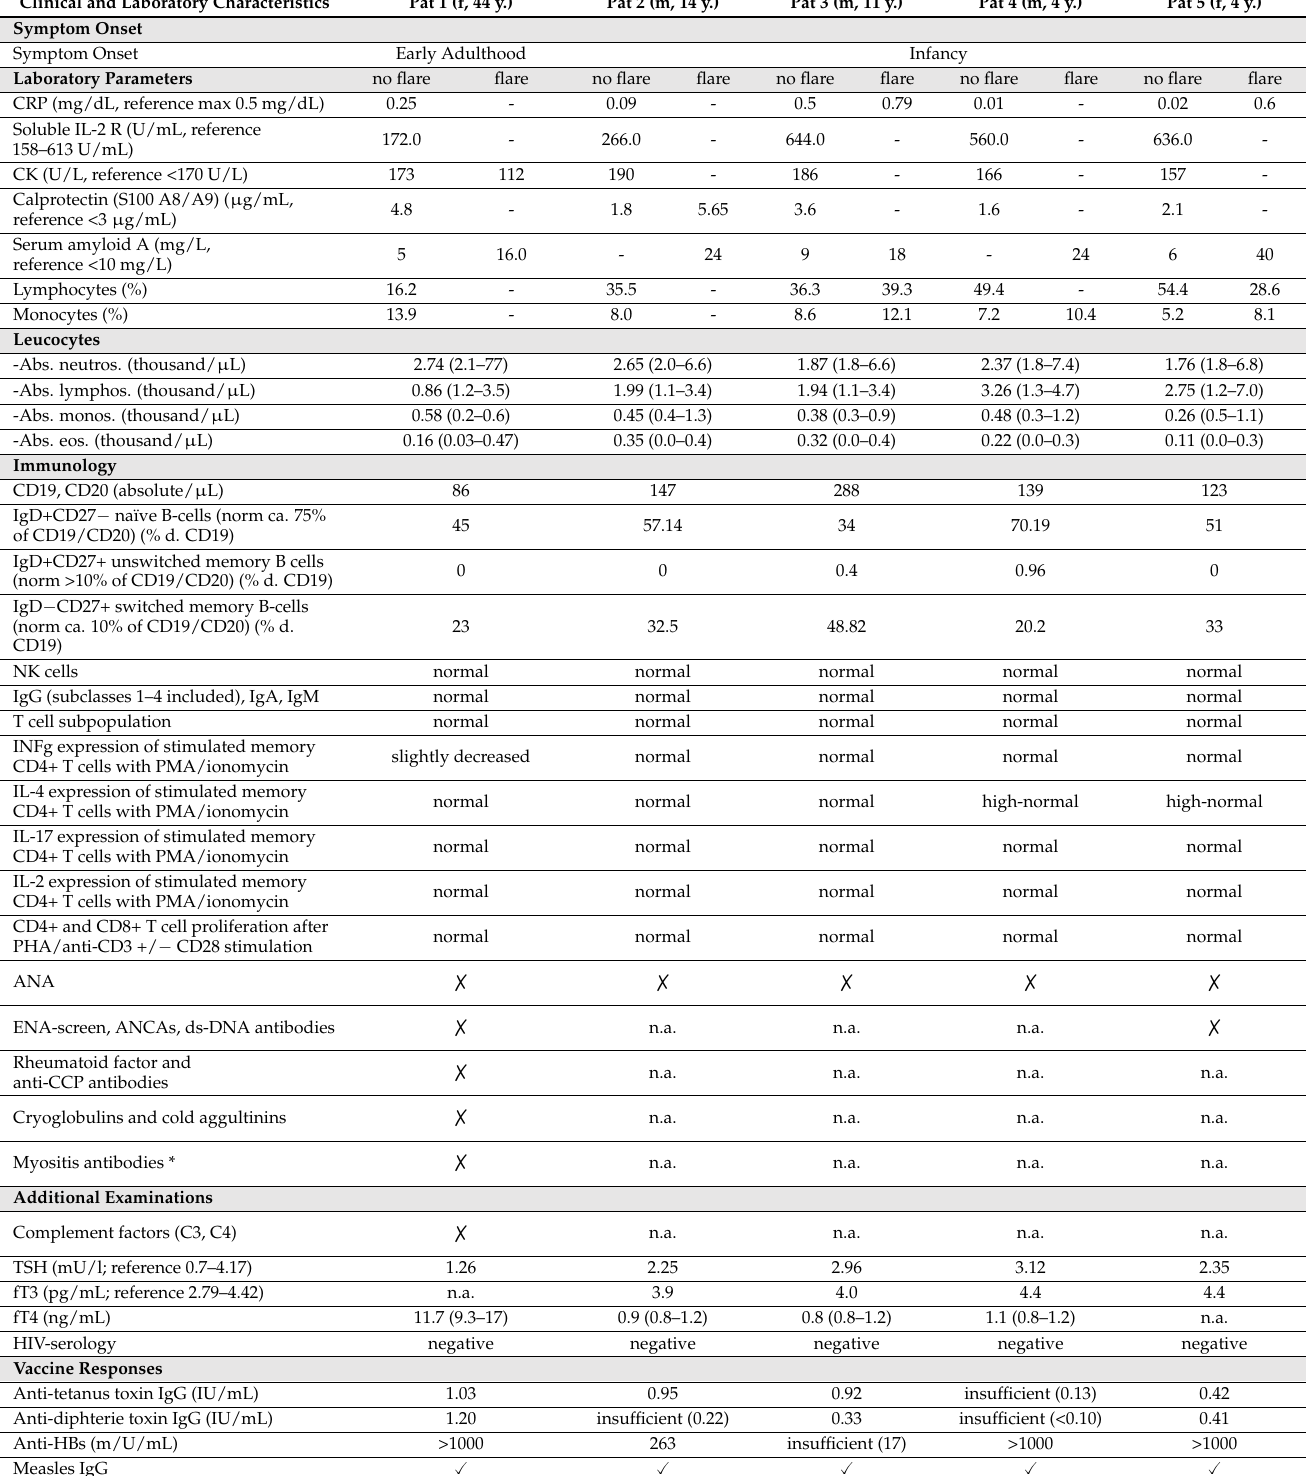
Table 1. Clinical and laboratory characteristics of patients with the heterozygous missense PLCG2 variant (c.77C>T, p.Thr26Met).